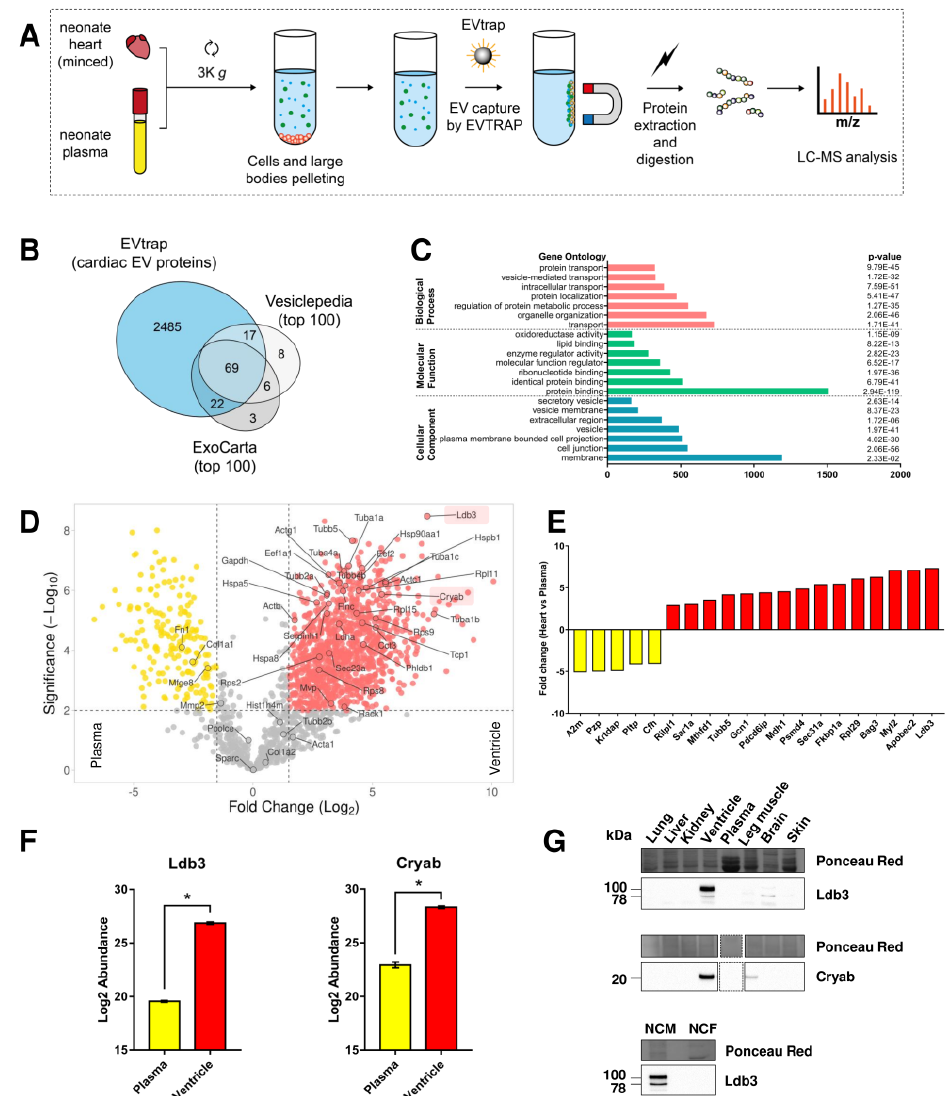
Figure 2. Proteomic analysis of neonatal rat heart and plasma EVs isolated by lipidic affinity. ( A ) Isolation of cardiac and plasma EVs (n = 4) using EV Total Recovery And Purification (EVtrap). Ventricles of 1–3 day old Wistar rats were minced using fine scissors before being resuspended in ice-cold ADS buffer. EVs were purified from ADS (cardiac) and plasma by binding to magnetic beads with lipidic affinity to membrane-bound particles, then lysed for analysis by liquid chromatography-mass spectrometry (LC-MS). K: × 1000. ( B ) Venn diagram of cardiac EV proteins (blue) compared to top 100 EV proteins identified in the public databases Vesiclepedia and ExoCarta. ( C ) GO analysis on the cardiac EV proteins to identify enriched GO terms. ( D ) Volcano plot comparing cardiac (red dots) and plasma (yellow dots) EV protein abundances. Proteins with p value < 0.01 and fold change > 1.5 were considered significant for the analysis. Only proteins detected by previous MALDI-TOF analysis, in addition to Ldb3 (LIM domain binding 3) and Cryab (Alpha-crystallin B chain), were labeled. ( E ) Bar plot representing the most significantly different (lowest p -value) proteins in plasma (yellow bars) and cardiac (red bars) EVs. ( F ) Bar plot of Ldb3 and Cryab abundances (log2 transformed) in plasma and heart. Error bars = SEM, * p < 0.05. ( G ) Quantification by Western blot of Ldb3 and Cryab expression in different tissues obtained from neonatal rat (upper panel) and in neonate cardiac myocytes (NCM) and fibroblasts (NCF) (lower panel). Equal amount of proteins were loaded for each blot as shown by Ponceau Red staining.